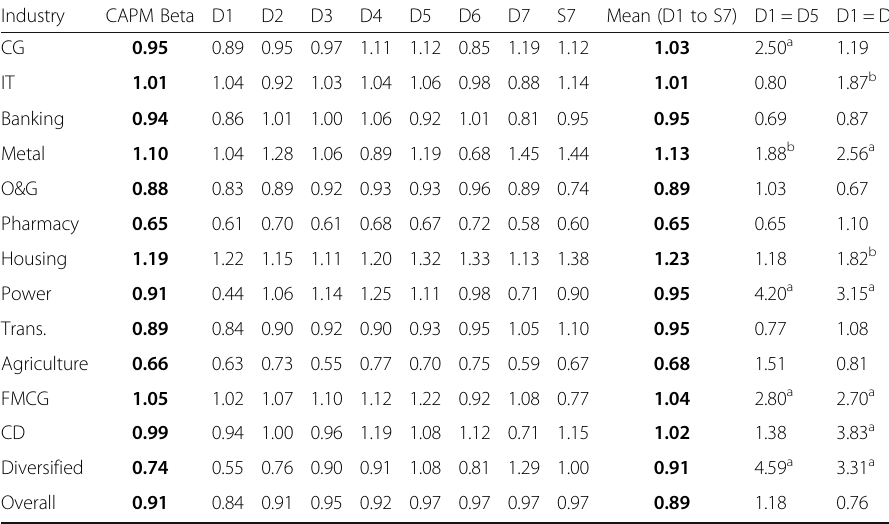
Table 3 Wavelet betas for Mid Cap